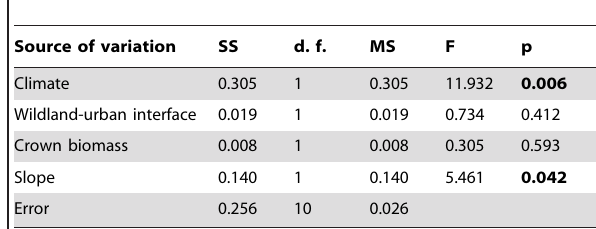
Table 2. Statistical results from the General Linear Model for the effects of climate, wildland-urban interface, crown biomass and slope on extreme